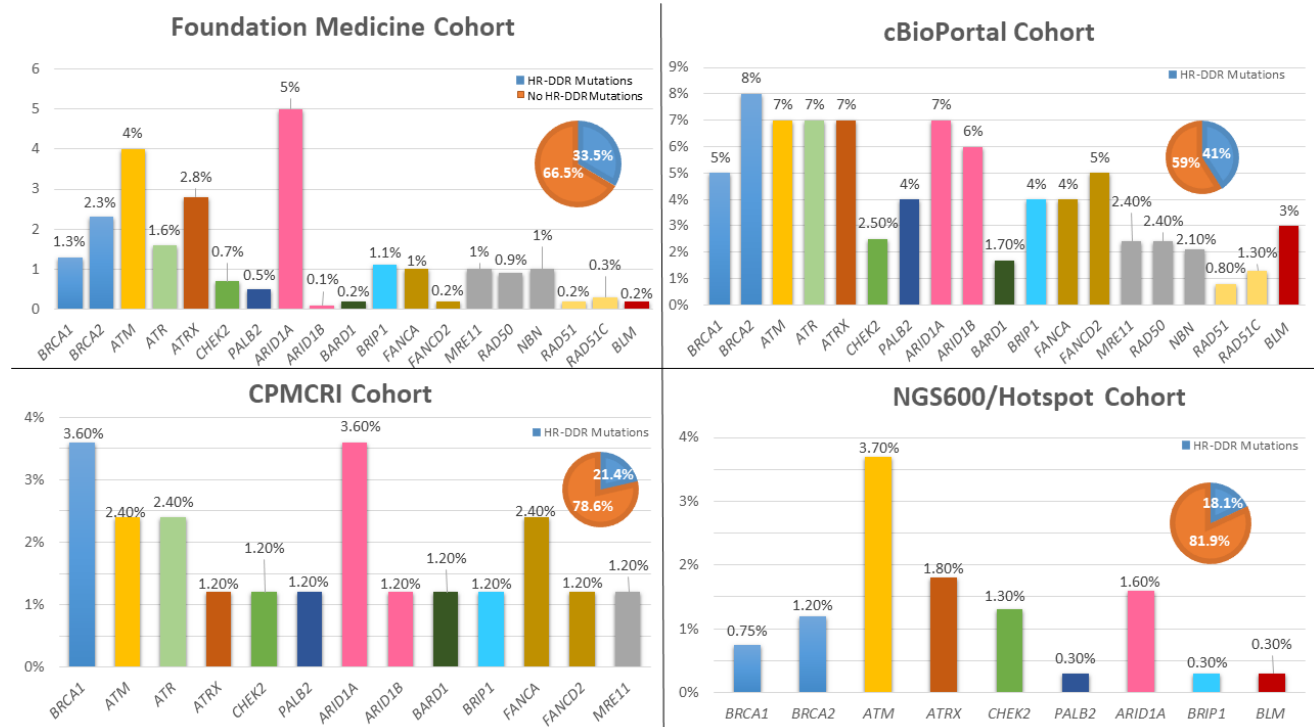
Figure 5. Frequency of commonly mutated genes of the HR-DDR pathway in melanomas from different cohorts including: FoundationOne medicine ( n = 1986), cBioPortal (1088), CPMCRI (84), and NGS600/Hotspot ( n = 670) cohorts. Bar charts represent the percentage of specific gene mutations in each cohort. Pie charts represent the percentage of melanoma samples with at least one mutation in the HR-DDR pathway. HR-DDR: Homologous recombination-DNA damage response. Pie charts: blue color represents the percentage of melanoma specimens harboring at least 1 mutant gene from homologous recombination pathway. The orange color represents percentage of melanoma specimens without homologous recombination gene mutations. CPMCRI: California Pacific Medical Center Research Institute. NGS: Next-generation Sequencing.